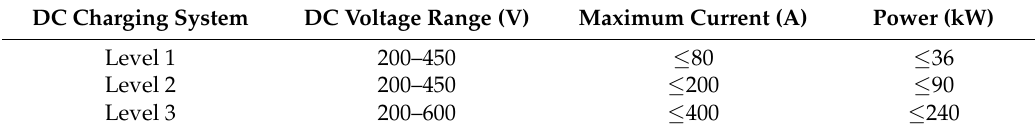
Table 20. SAE (Society of Automotive Engineers) DC charging characteristics. Data from